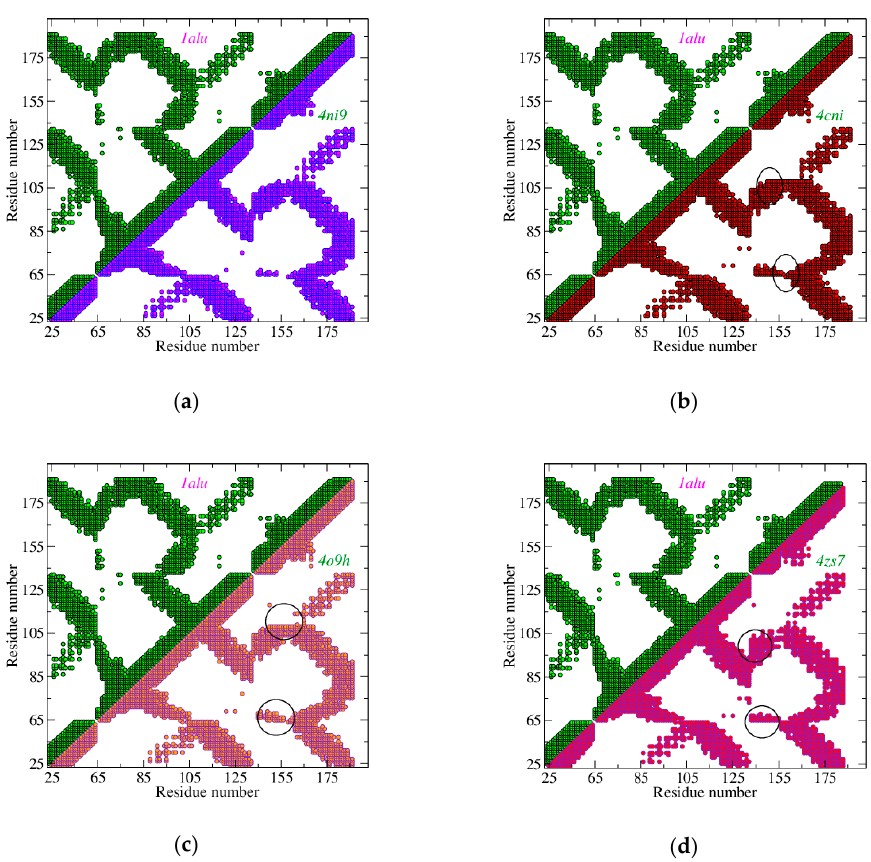
Figure 3. Contact maps of IL-6, in the native state and the active state, due to the conjugation with di ff erent receptors, D = 15 Å. ( a ) IL-6 in the native state (green) vs. IL-6 in the active state due to the conjugation with SL1025 SOMAmer (blue); ( b ) IL-6 in the native state (green) vs. IL-6 in the active state due to conjugation with OKZ Fab (red); ( c ) IL-6 in the native state (green) vs. IL-6 in the active state due to conjugation with 61H7 Fab (pink); ( d ) IL-6 in the native state (green) vs. IL-6 in the active state due to conjugation with 68F2 Fab (magenta). Main di ff erences with the native states have been marked with an ellipse.